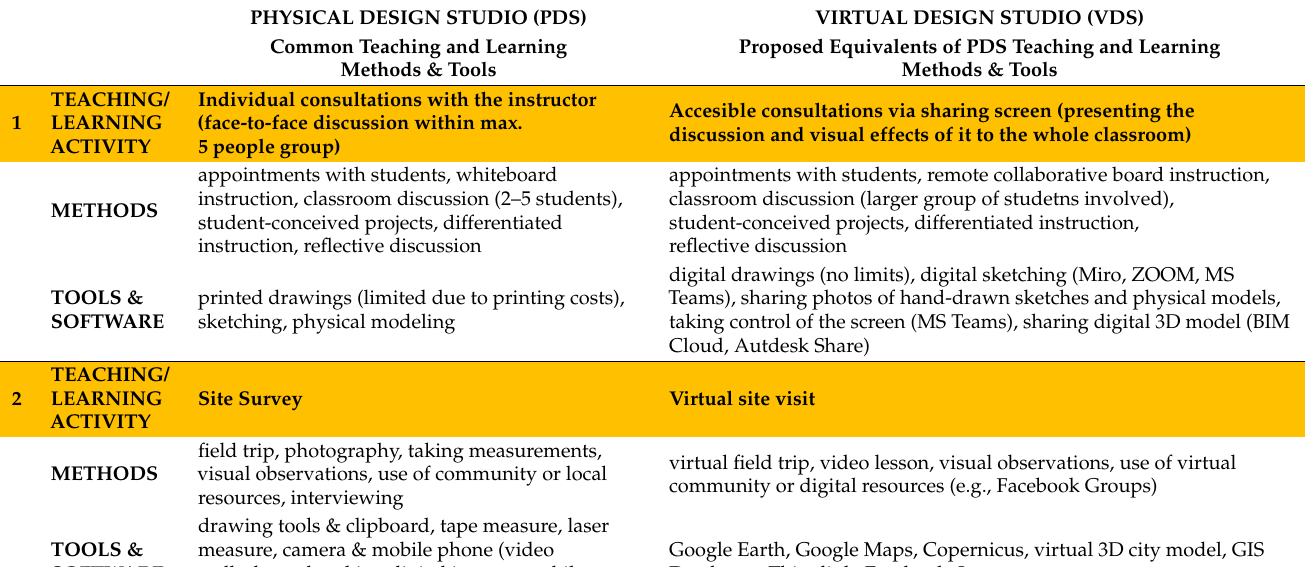
Table 1. Result of the TDT meeting: list of common teaching and learning methods and tools used in PDS translated into a VDS